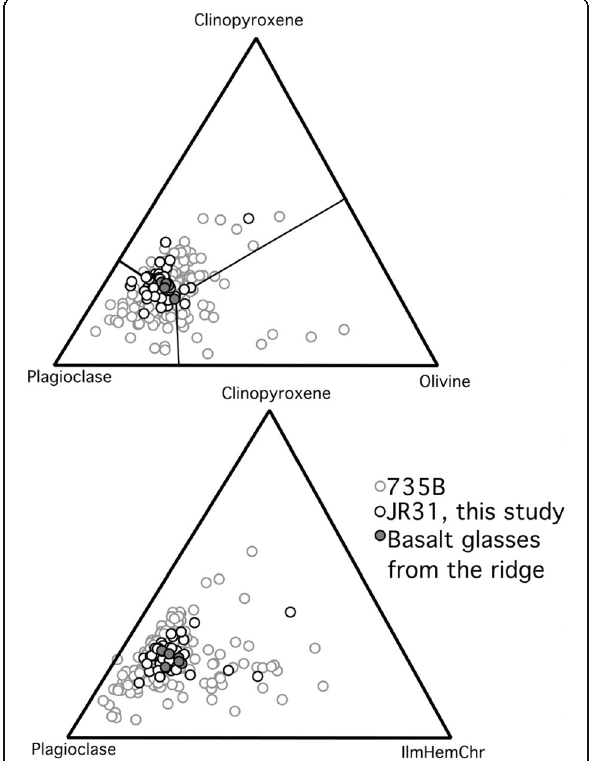
Fig. 9 Calculated mineral norms for Atlantis Bank gabbros, and average Hole 735B compositions from whole-rock data using the method of Grove et al. (1992a, 1992b). The cotectic lines in the uppermost figure represent the 1 atm olivine-plagioclase-augite-melt saturation boundary based on SWIR basalt glass, thus indicating that these gabbros generally do not have a simple liquid composition and are therefore cumulates. Lower panel shows plagioclase- clinopyroxene-oxide plot for reference